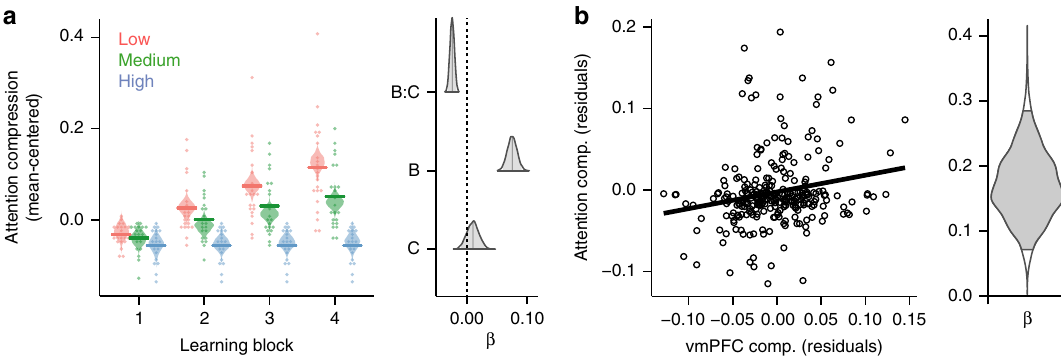
Fig. 3 Relationship between model-based attention weighting and vmPFC neural compression ( N = 23). a Attention compression (i.e., degree of attention selectivity as derived from cognitive model fi ts to behavior) emerged according to feature relevancy across the problems with highest compression for low complexity followed by medium and high complexity by the end of learning. Points depict individual participants, horizontal lines are group averages, and violin plots depict the distribution of posterior predictions from the Bayesian-estimated linear regression. The right panel depicts posterior distributions of regression coef fi cients for learning block ( b ), complexity ( c ), and their interaction ( b : c ). The shaded region within the distributions marks the 95% high-density interval. b vmPFC neural compression predicted the degree of problem-speci fi c computational model-based attention compression across learning blocks and problems. Both vmPFC neural compression and model-based attention compression are plotted as partial residuals of separate regression models that regress out factors of learning block, problem complexity, accuracy, and learning order. The solid line depicts the best- fi tting regression line of the partial residuals. The violin plot depicts the posterior distribution of regression coef fi cient relating neural compression and attention compression. The shaded area bounded by black lines within the distribution mark the 95% high-density